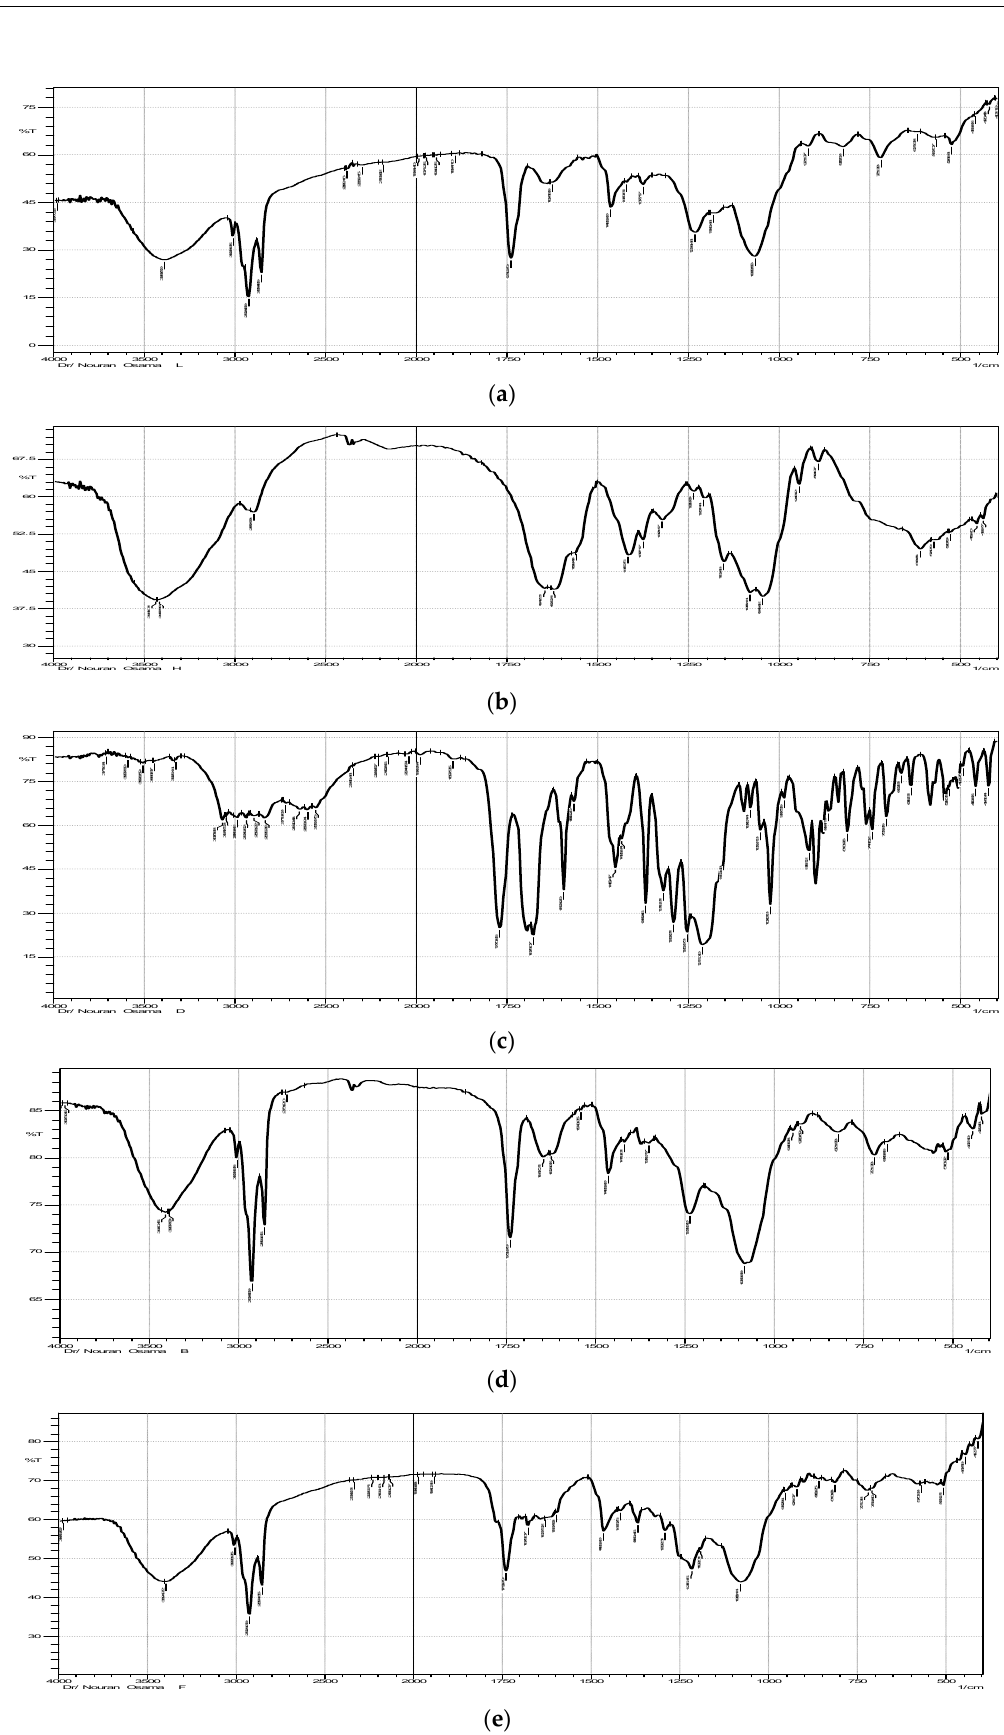
Figure 4. FT- IR spectra of Soya lecithin ( a ), HA ( b ), DCN ( c ), Blank formulation ( d ), and the optimized hyaluosome formulation (F7) ( e ) .